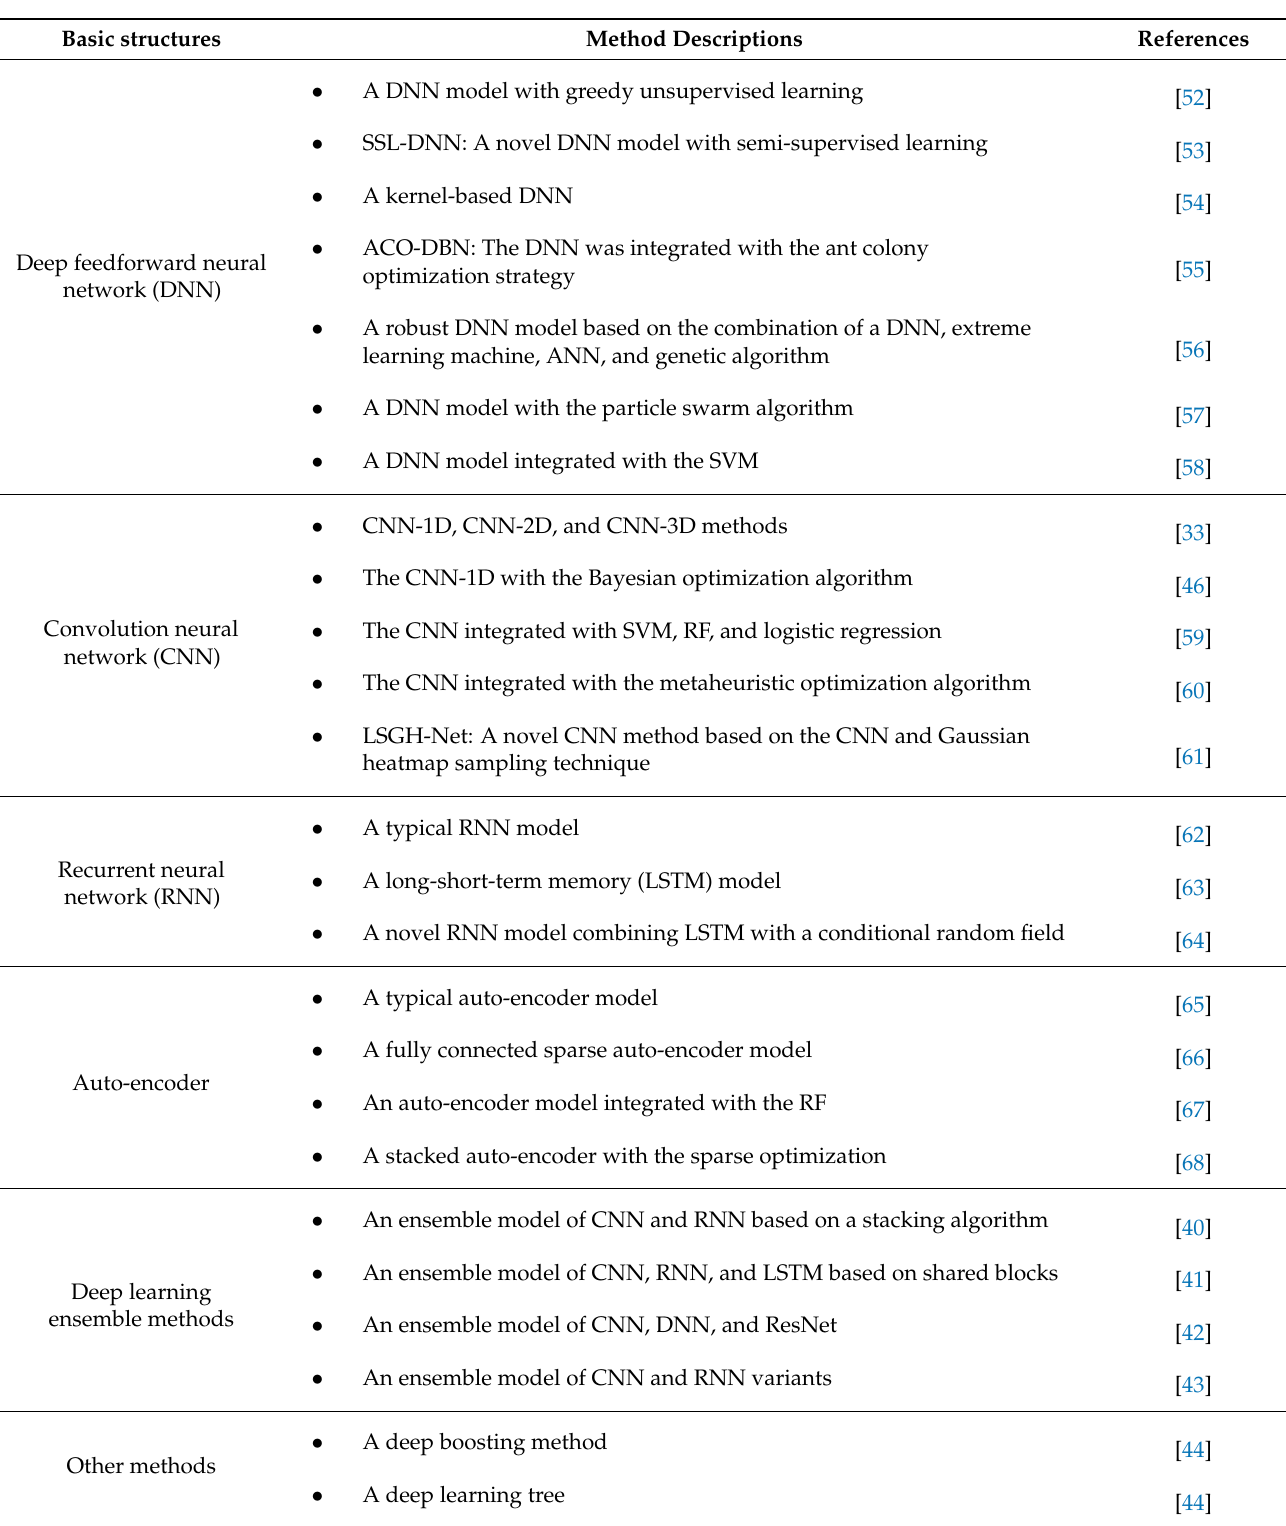
Table 1. A summary of the existing deep learning-based LSM methods. Basic